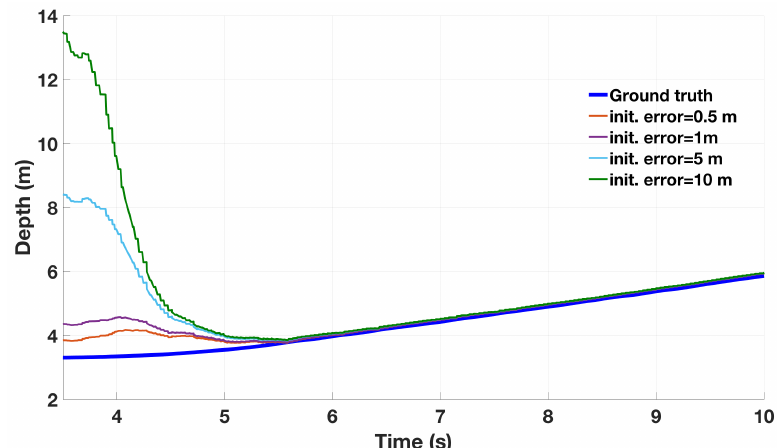
Figure 11. Influence of initial guess on accuracy and convergence. The depth estimation algorithm based on motion parallax is robust against initialization errors.